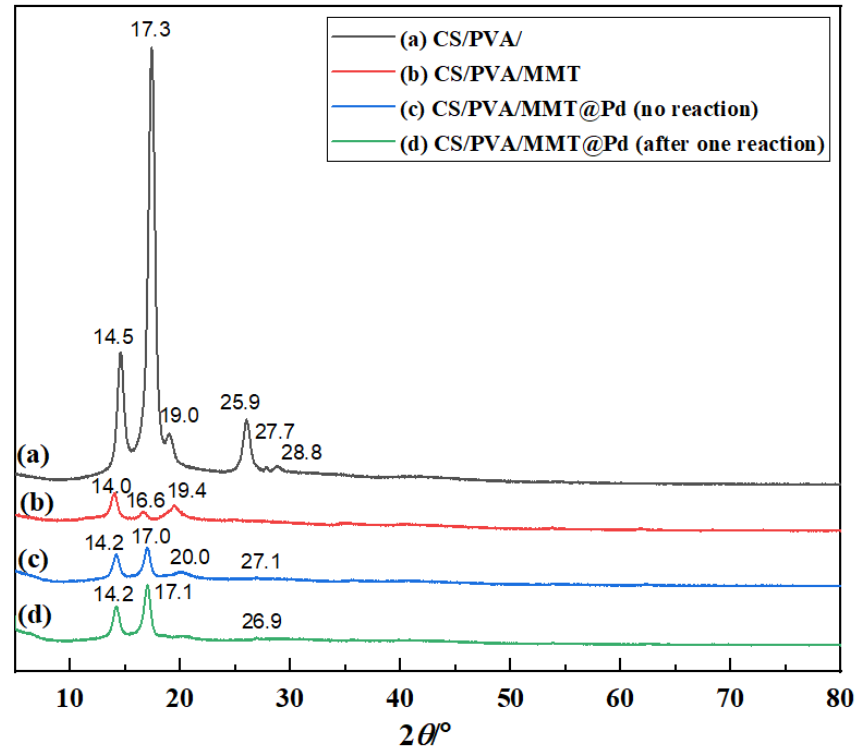
Figure 7. X-ray diffraction patterns of ( a ) CS/PVA, ( b ) CS/PVA/MMT, ( c ) CS/PVA/MMT @Pd (no reaction), and ( d ) CS/PVA/MMT @Pd (after one reaction).